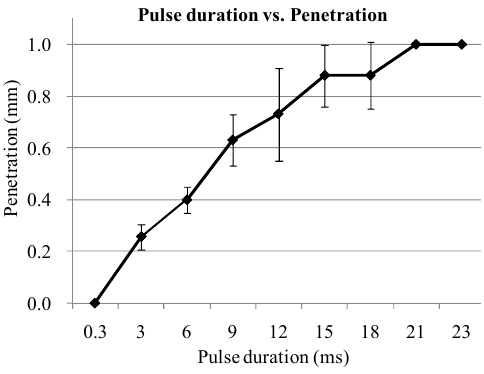
Figure 10. The effects of pulse duration on weld penetration.